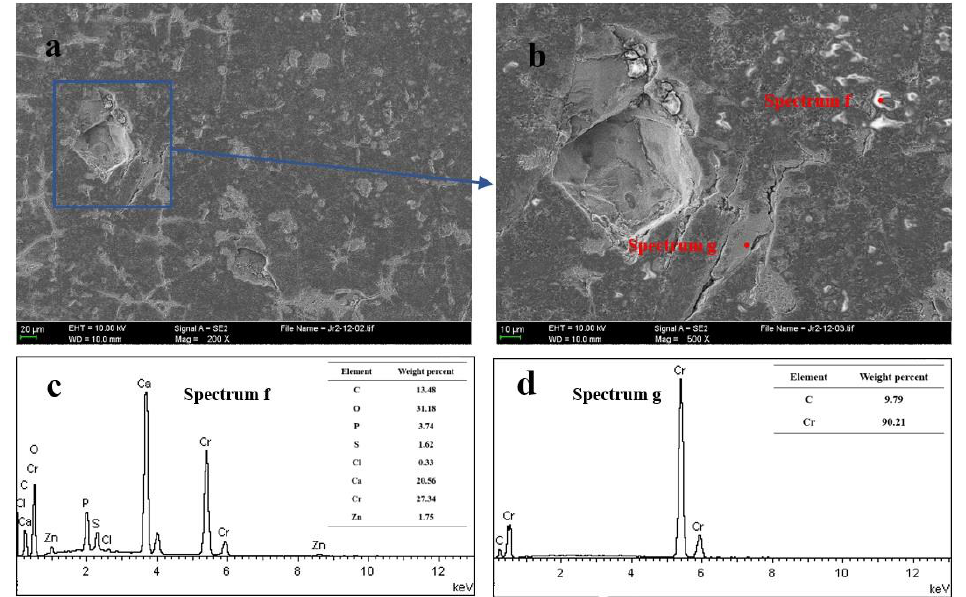
Figure 11. Surface topography ( a ), enlarged area topography ( b ) and position f ( c ) and position g ( d ) element contents of Cr coated piston ring.